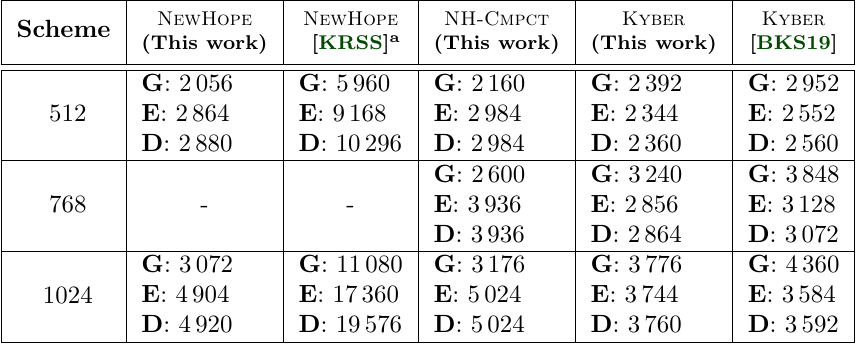
Table 4: Stack usage comparison for the {R,M}LWE schemes improved by our work. G : key generation, E : encapsulation, D : decapsulation.